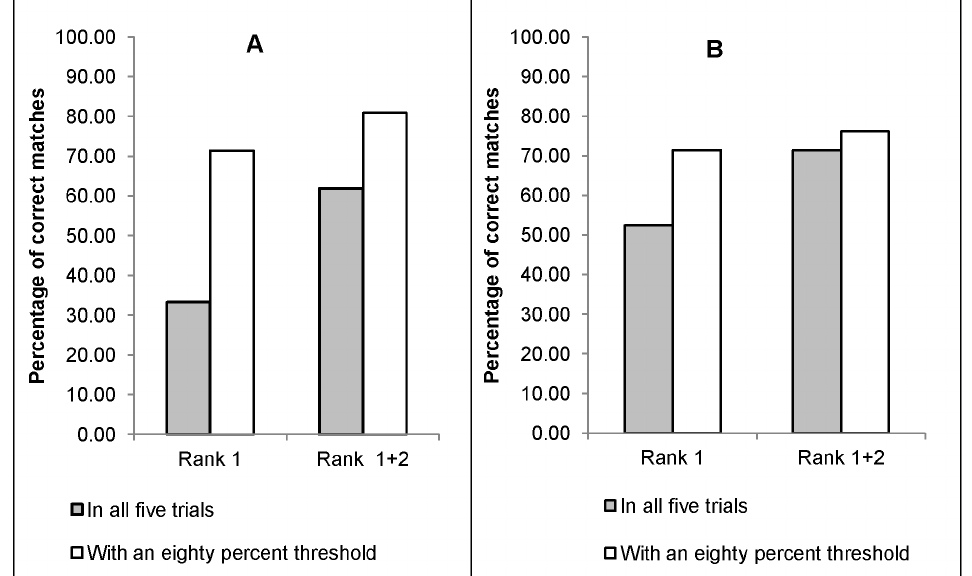
Figure 5. Percentage of correct matches from (A) the human assessment and (B) the computational method.